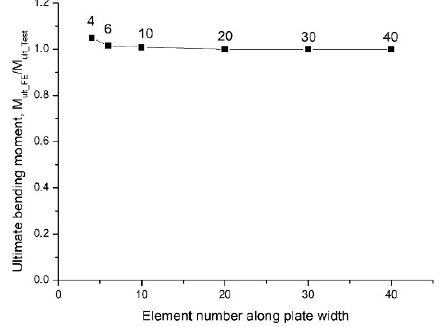
Figure 4. Ultimate bending moment of box girder with various meshing density under static load (initial imperfection assumed as 2 half-wave with the amplitude 0.9 mm).